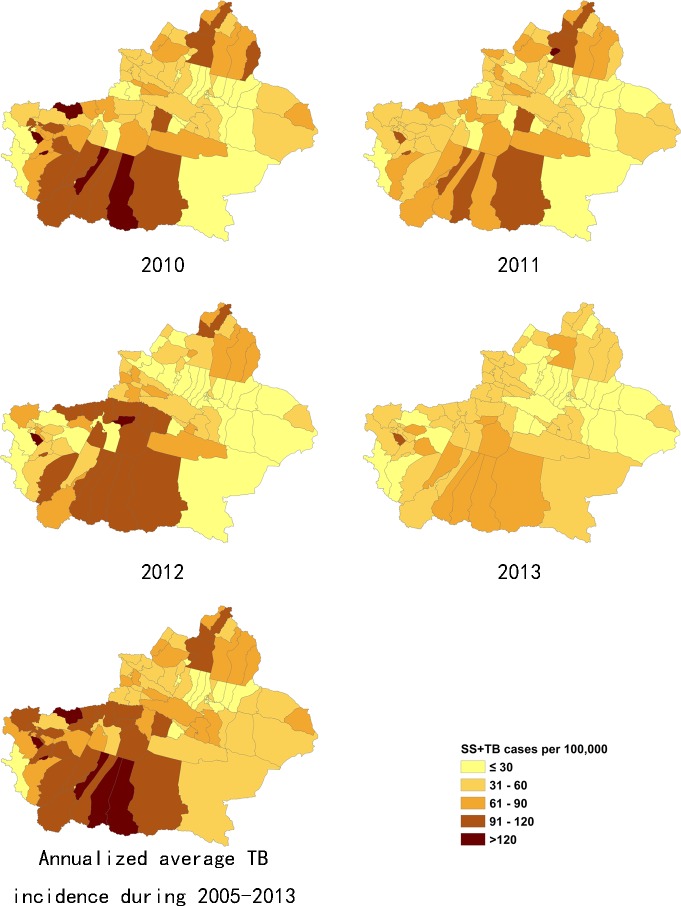
The incidence of SS+TB cases in Xinjiang, from 2010–2013.